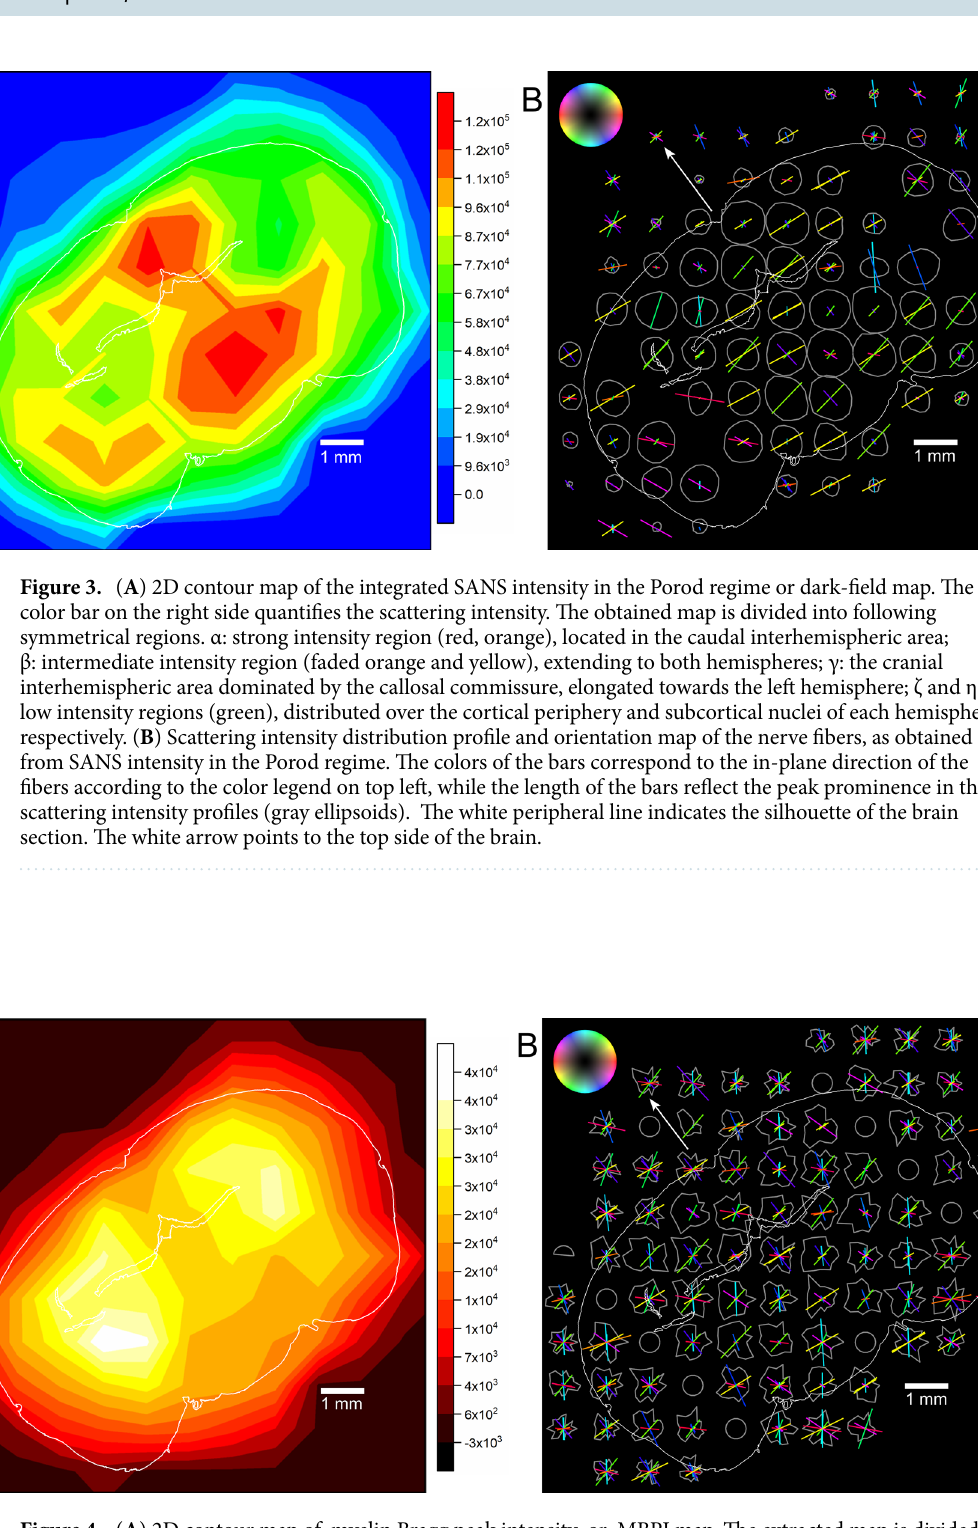
Figure 4. ( A ) 2D contour map of myelin Bragg peak intensity or MBPI map. The extracted map is divided into following symmetrical regions. Π: high scattering intensity area (white), located at symmetrically opposite position and almost at the middle of each hemisphere; Σ: extended Σ-region with an intermediate scattering intensity (white + yellow); ∆ : relatively low scattering area (faded yellow), at the bridging area of two Σ-regions; Ω: lowest scattering intensity region (orange), distributed mostly over the gray matter. ( B ) Bragg peak intensity distribution profile and orientation map of the myelin sheath/fibers as obtained from the SANS intensity in the Bragg regime. The colors of the bars correspond to the in-plane direction of the myelin sheath/fibers according to the color legend on top left, while the length of the bars reflect the prominence of the Bragg peaks in the scattering intensity profiles (gray fingerprints). The white peripheral line indicates the silhouette of the brain section. The white arrow points to the top side of the brain. 10 measurements inside the tissue (gray circles) were skipped due to time